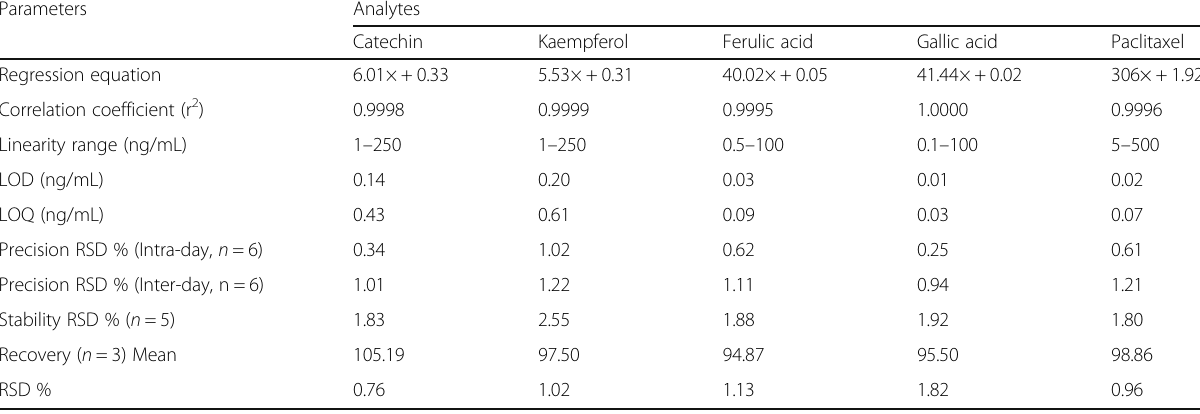
Table 4 Method validation parameters for five reference analytes